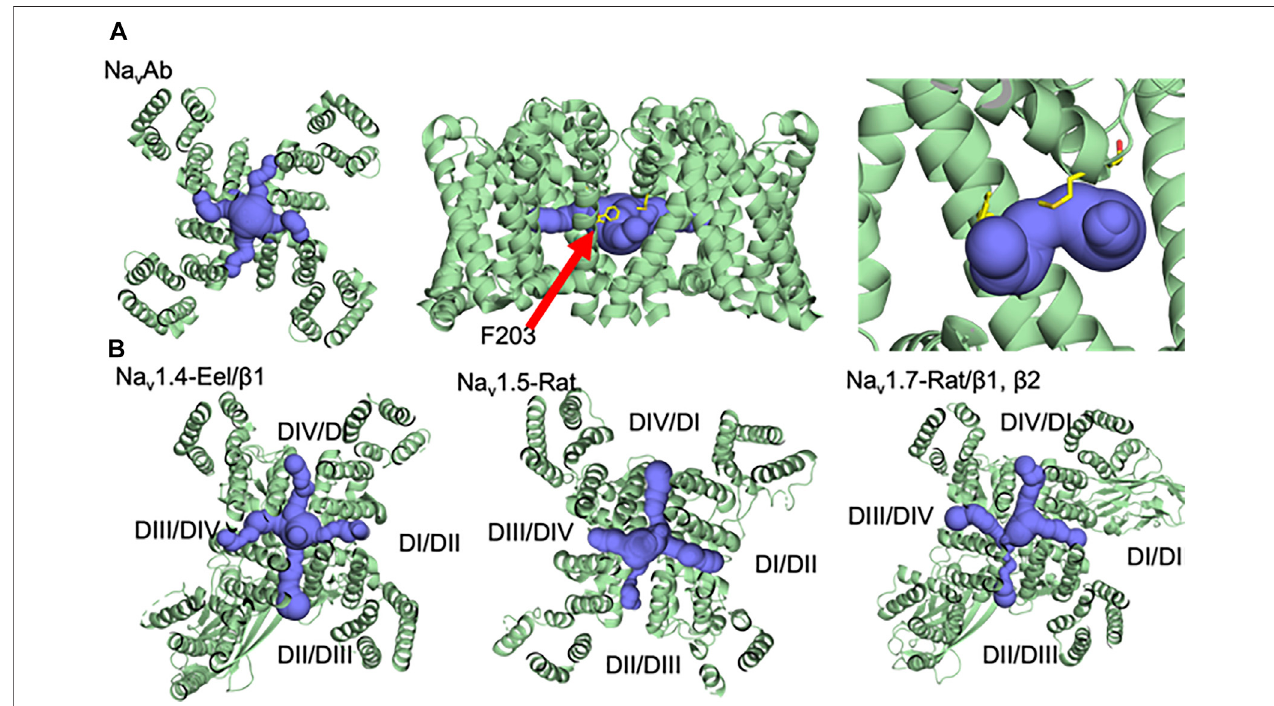
FIGURE2 | Fenestrations with different sizes and architecture ina variety ofvoltage-gated sodium channels (A) Na v Ab, (B) Na v 1.4, Na v 1.5, and Na v 1.7 (Pan et al., 2018; Xu et al., 2019; Jiang et al., 2020).